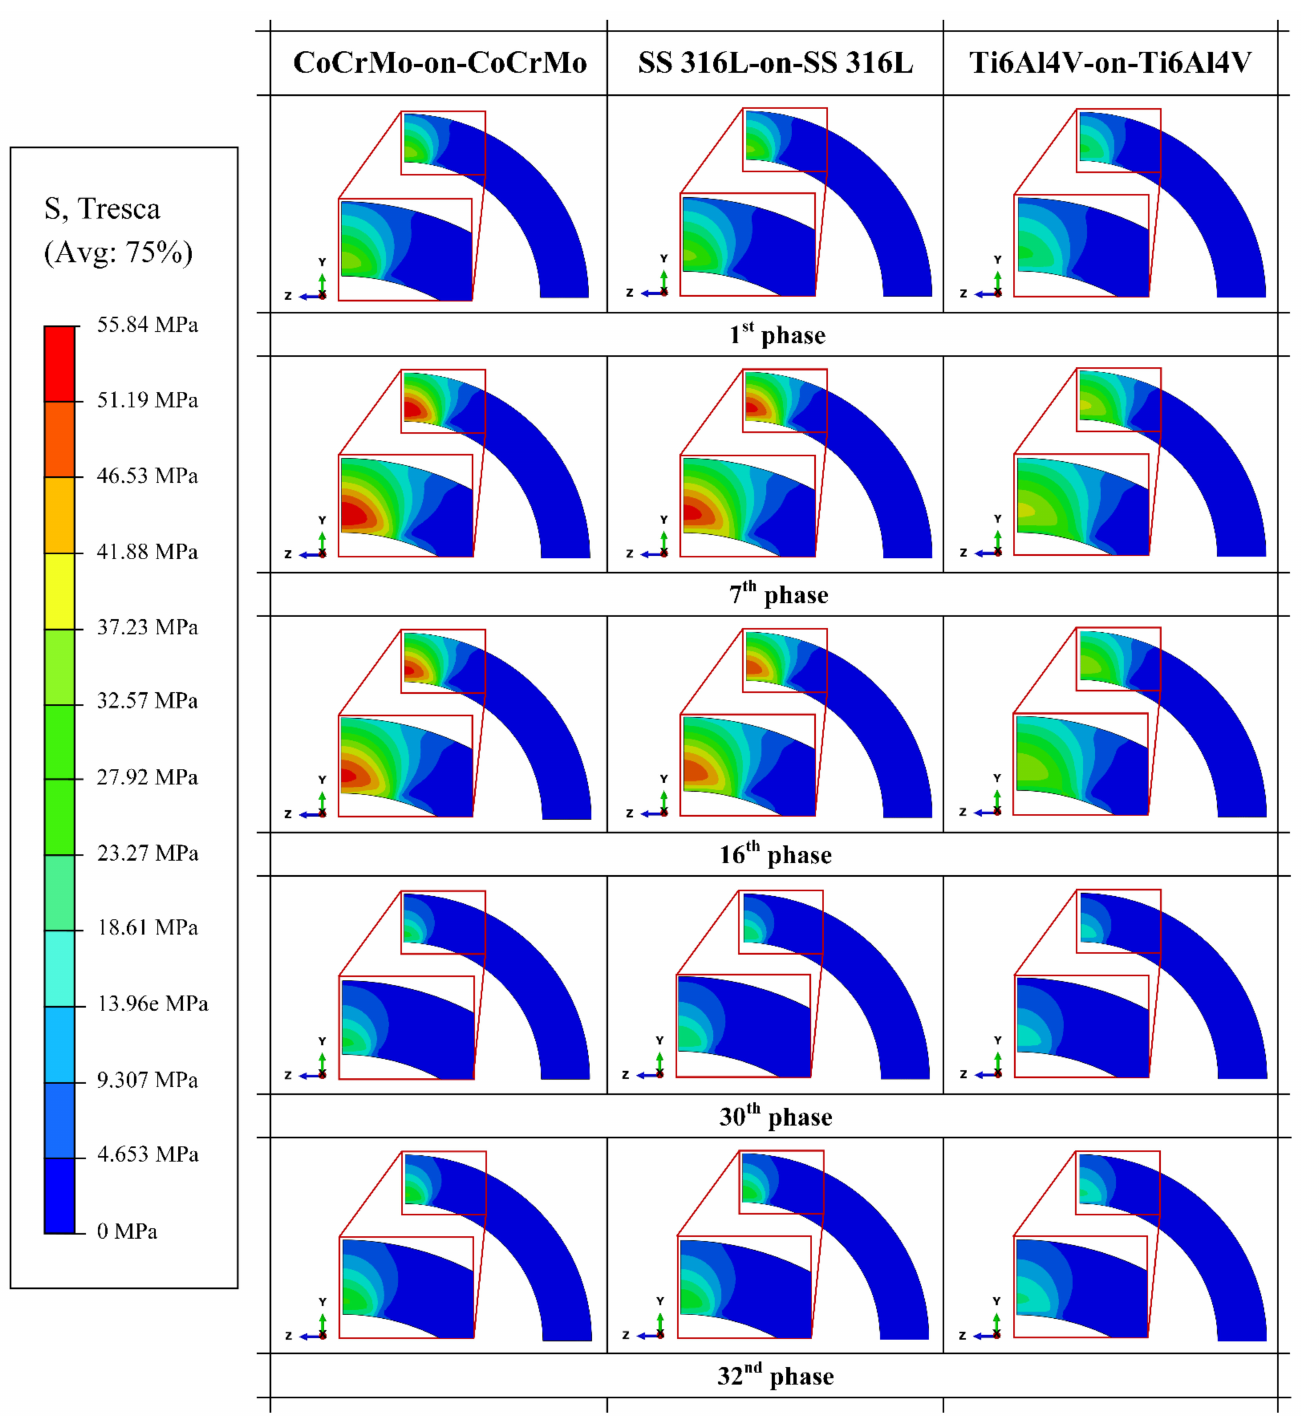
Figure 5. Tresca stress distribution on the acetabular cup for different metal-on-metal bearing materials at selected phases. The relationship between Tresca stress and acetabular cup thickness on metal-on-metal bearings with different metallic materials during the peak phase and selected phase is illustrated in Figures 6 and 7. The highest Tresca stress does not occur in the surface contact but in the bulk area that is very prone to losing its elastic properties. In addition, the